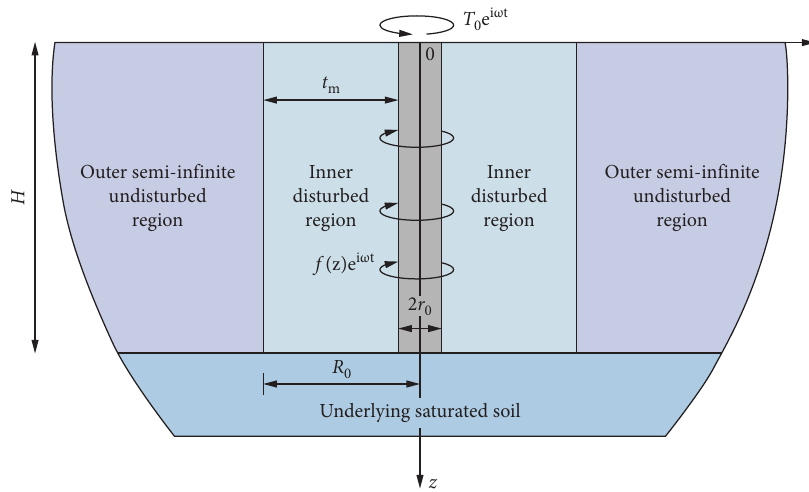
Figure 1: Dynamic torsional interaction between an elastic pile and a radially inhomogeneous saturated soil.